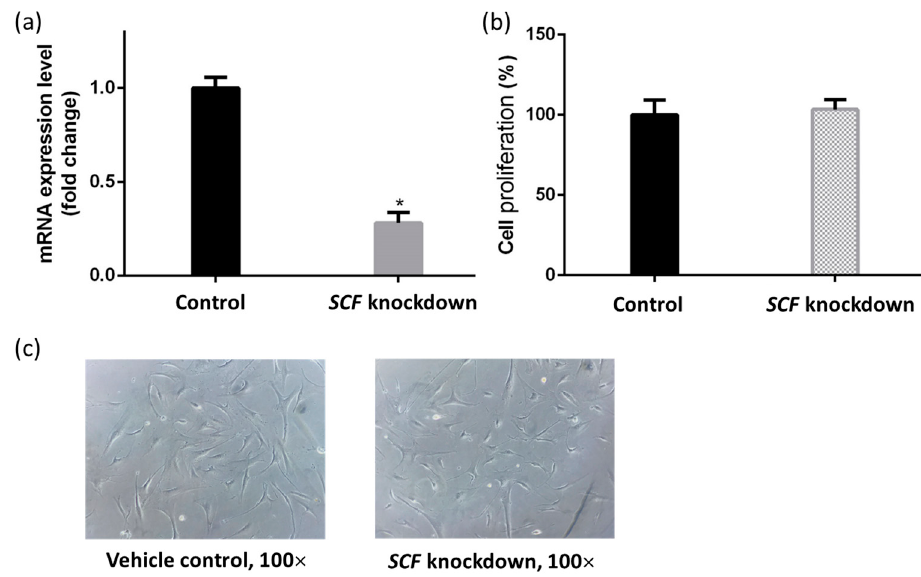
Figure 1. Validation of fibroblasts after SCF targeted siRNA 25 nM transfection for 48 h. ( a ) The 75% gene knockdown efficiency of SCF in fibroblasts; ( b ) Fibroblasts were treated with 25 nM SCF -targeted siRNA for 48 h, and the proliferation was assessed by MTT assay; ( c ) Phase-contrast images compared between control and SCF gene knockdown fibroblasts (100 × ). The data are presented as means ± SD; n = 3, * p < 0.05.